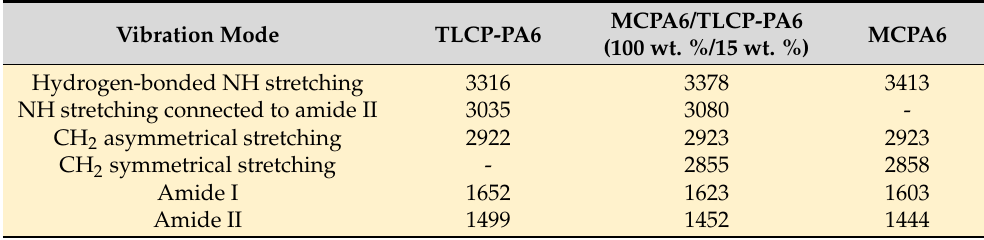
Table 2. FT-IR results of different